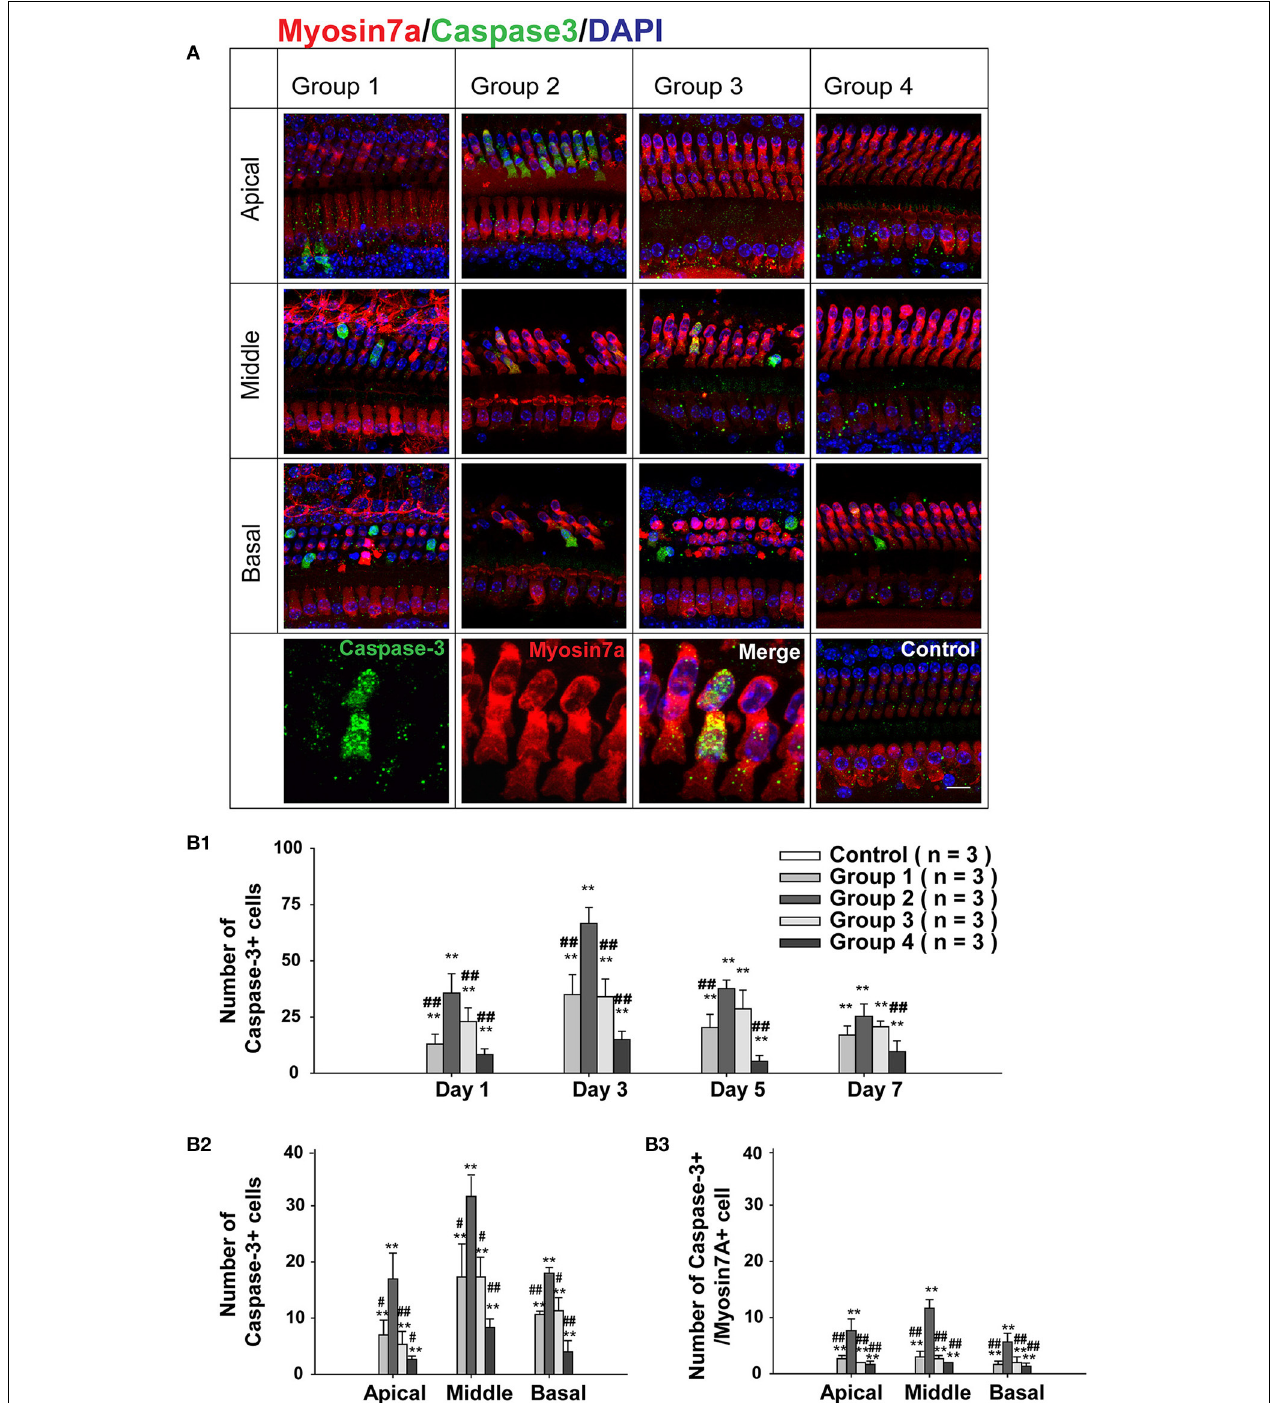
FIGURE 4 | Caspase-3 expression after neomycin treatment. (A) Representative confocal images of all three turns of the cochlea stained with myo7a and cleaved caspase-3 in WT mice sacrificed 3 days after the last injection of neomycin or saline (control). Neomycin or saline was injected between P1 and P7 (Group 1), P8 and P14 (Group 2), P15 and P21 (Group 3), or P60 and P66 (Group 4). (B1) The number of caspase-3 + cells in the whole cochlea of WT mice treated with neomycin or saline (control) between P1 and P7 (Group 1), P8 and P14 (Group 2), P15 and P21 (Group